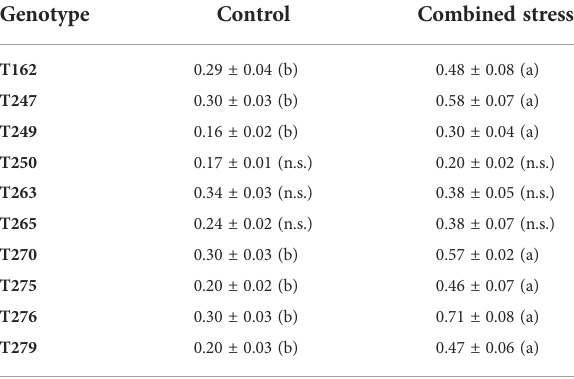
TABLE 2 Root/shoot ratio in control and combined stress treatments. Genotype